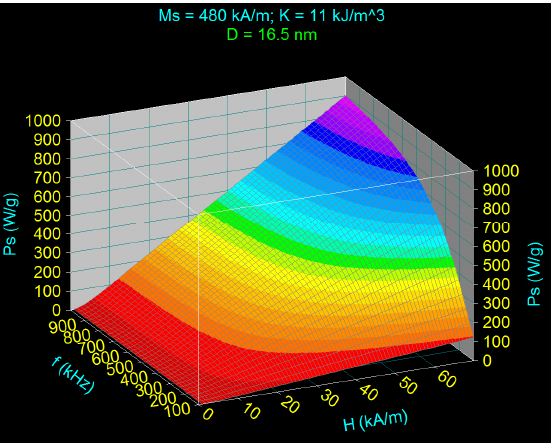
Figure 3. Maximum specific loss power depending on the amplitude and frequency of the AMF, for the diameter of the nanoparticle corresponding to the maximum power.